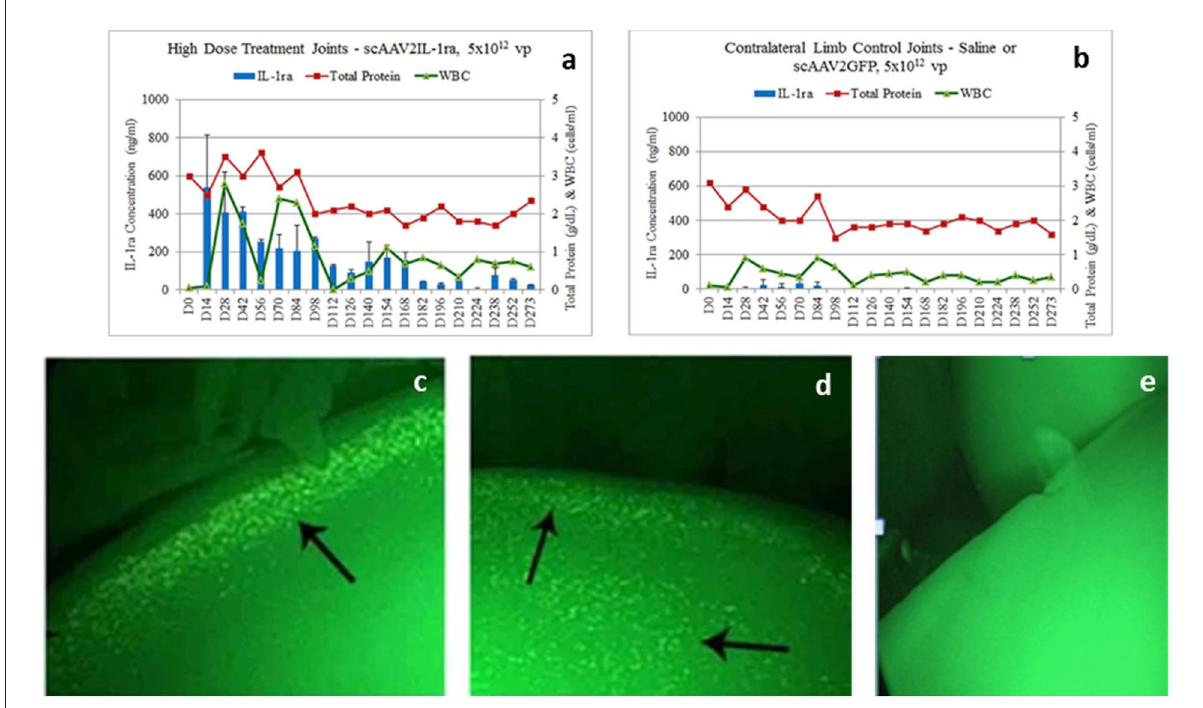
FIGURE4 (a,b) IL-1Ra levels (blue bars), total protein levels (red line) and white blood cell (WBC) levels (green line) in the joints of horses in a scAAVIL-1Ra dosing trial. IL-1Ra levels remain elevated in joints injected with the highest dose of scAAVIL-1Ra (a) compared to the control joints (saline or scAAVGFP) (b) . Transduced joints produced very high levels of IL-1Ra (over 100ng/ml) for over 168 days after which, levels of IL-1Ra continued to be produced between 50–100ng/ml out to 273 days. WBC counts did not rise above normal (1,000 cells/ml) for joints injected